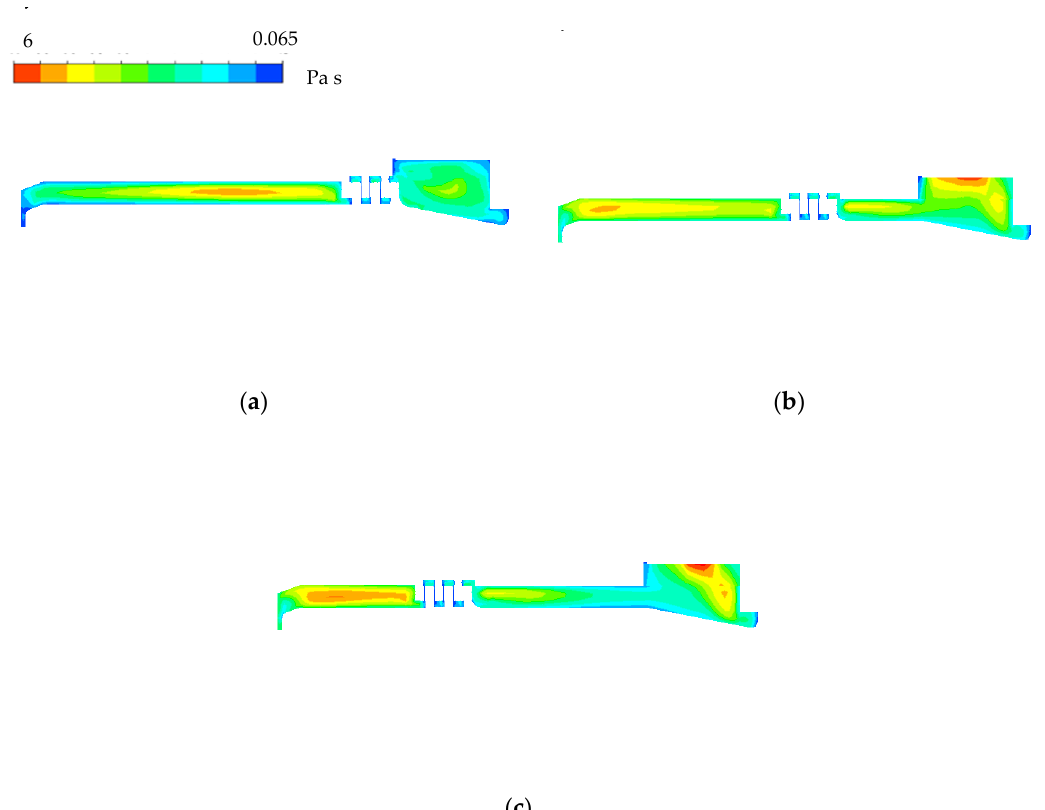
Figure 4. Comparison of efficiency. ( a ) 100% loading condition. ( b ) 75% loading condition.